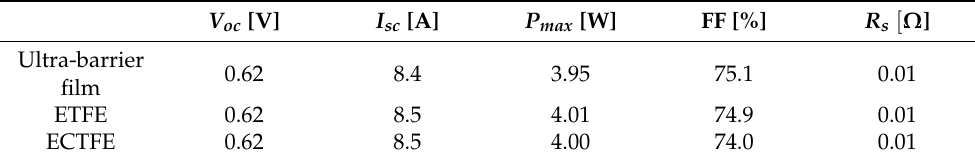
Figure 4. Actually, manufactured one-cell photo-voltaic (PV) module ( A ) Ultra-barrier film, ( B ) ETFE, ( C ) ECTFE. Table 2. Electrical output of one-cell PV module for each of the different front-surface materials.